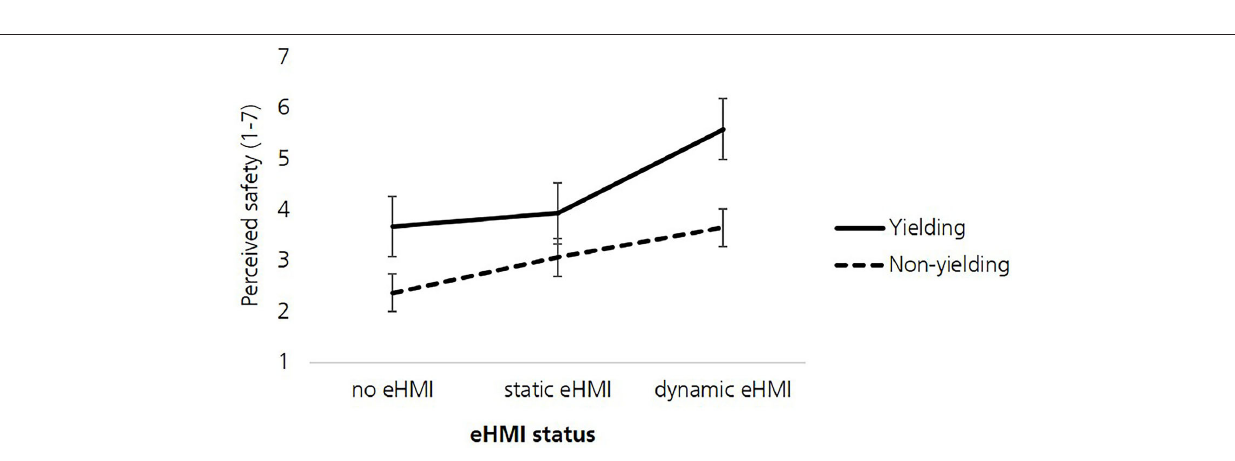
to when no contradictory explicit information was given by the